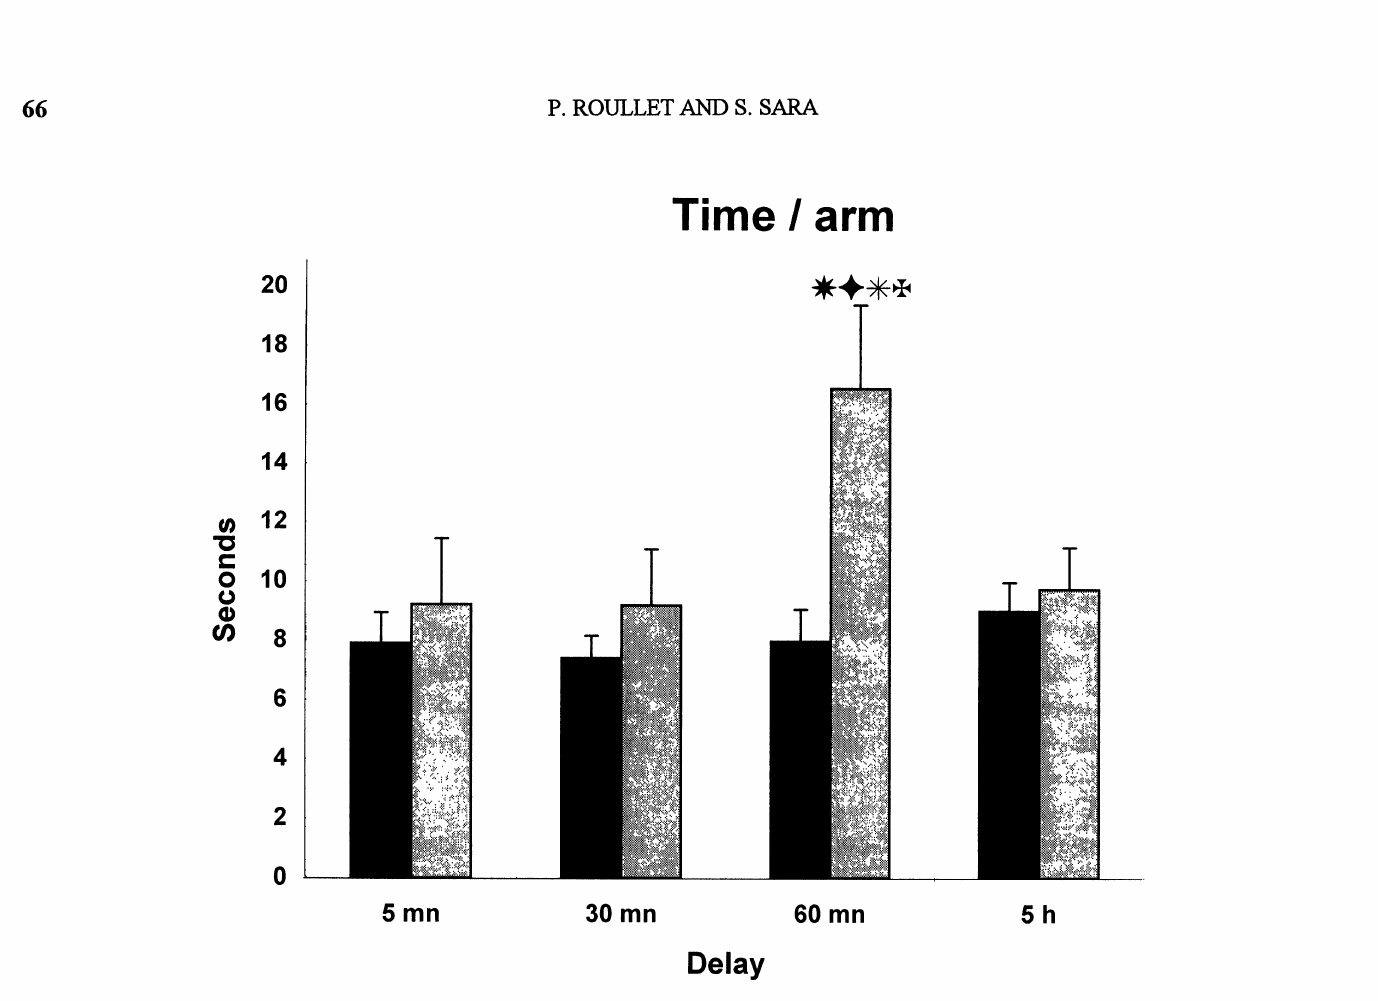
" Fig. 2: Time per arm. (mean + s.e.m.). control. C]" timolol. Rats injected with timolol 60 min. after the reactivation trial took significantly more time per arm than those of all other groups. p<.01 compared with saline group at the same delay; / p<.01 compared with timolol injected group at the delay 5 min.; p<.05 compared with timolol injected , group at the delay 30 min.; p<.05 compared with timolol injected group at the delay 5